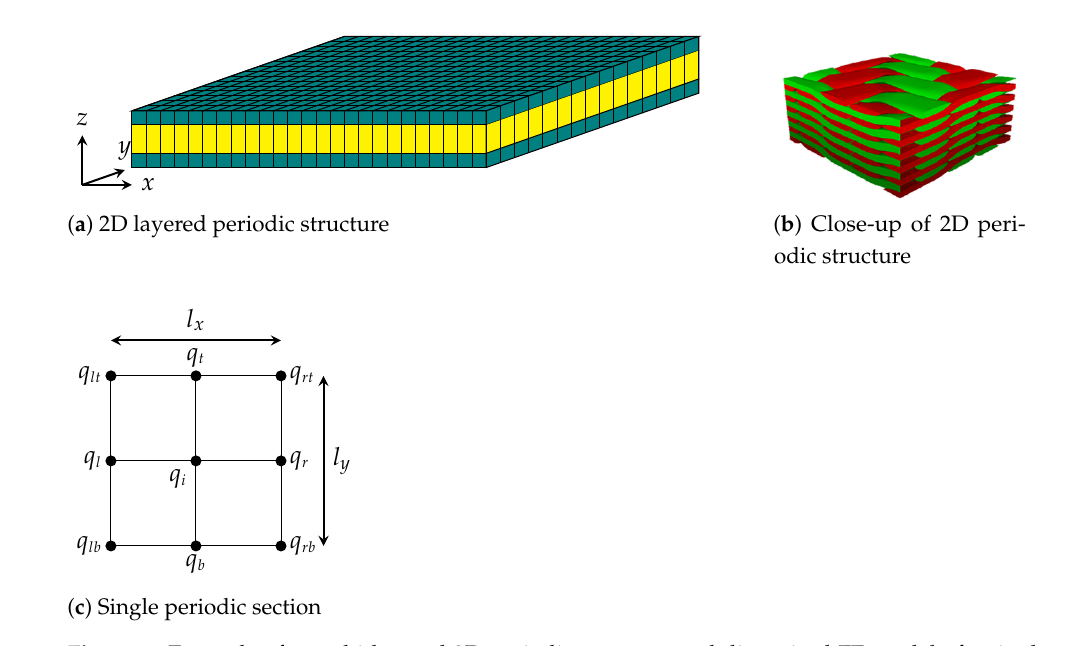
Figure 1. Example of a multi-layered 2D periodic structure and discretised FE model of a single periodic